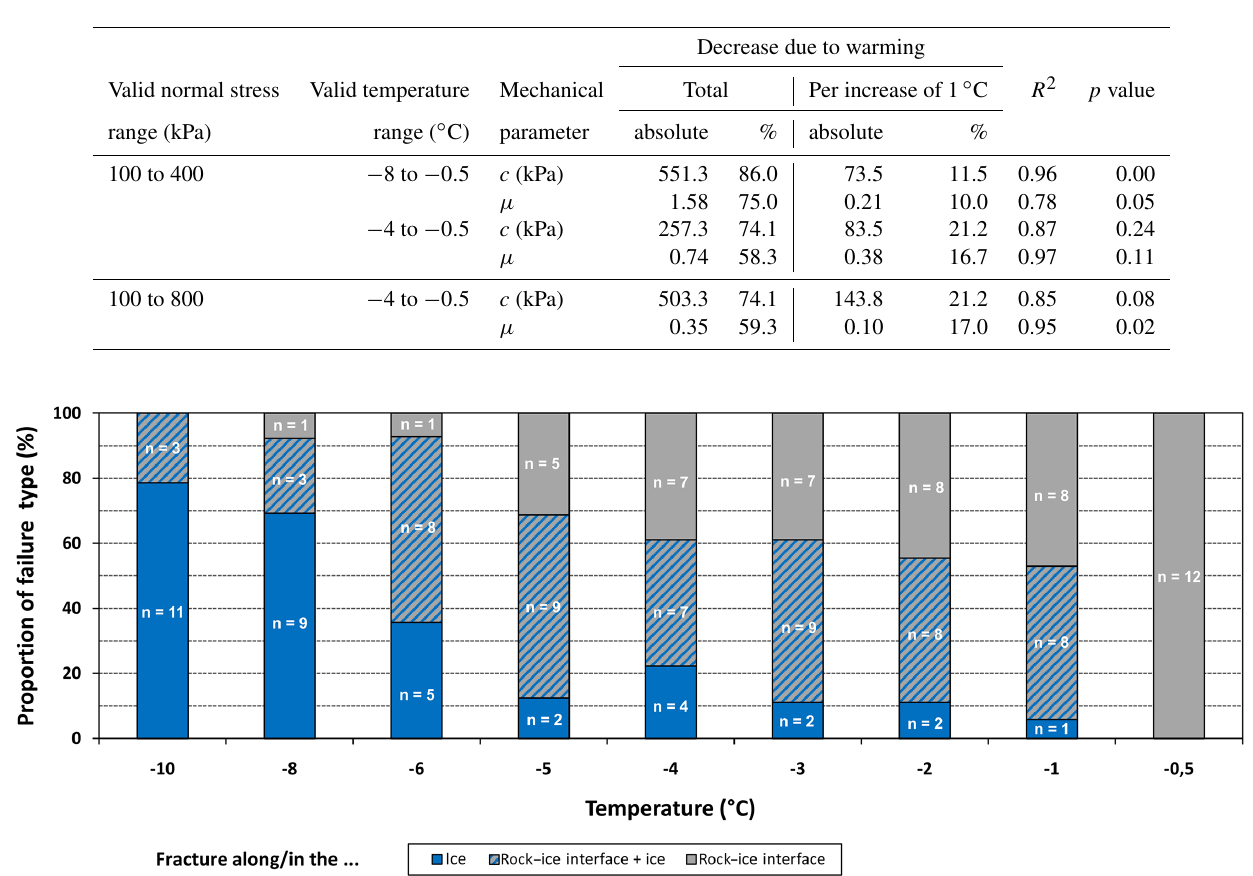
Figure 8. Proportions and absolute numbers of fracture types plotted at temperatures from − 10 to − 0 . 5 ◦ C (for tests at 100–800kPa). Failures inside the ice dominate at low temperatures whereas failure along rock–ice interfaces become more important close to 0 ◦